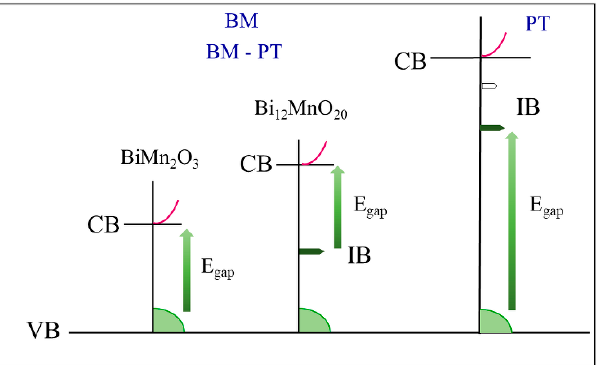
Figure 14. A schematic band, E gap , layout proposed for BM, BM-PT, and PT ceramics, obtained from performed Vis-NIR test.